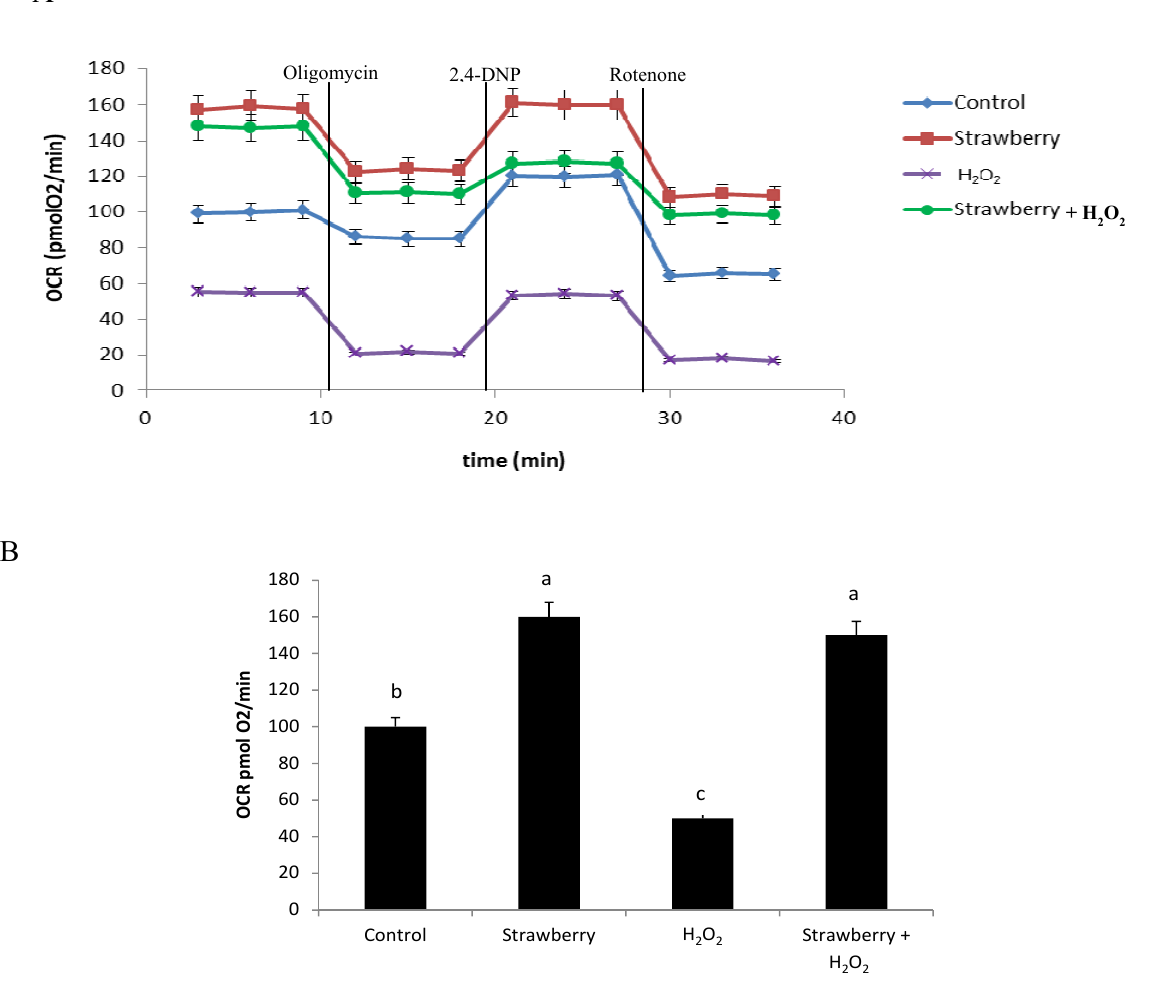
Figure 5. Evaluation of oxygen consumption rate (OCR) in control and in strawberry pre-treated fibroblasts, stressed with H Extracellular Flux Analyzer with the sequential injection of Oligomycin (1 µg/mL), 2,4-DNP (100 µM), Rotenone (1 µM) at the indicated time point into each well, after baseline rate measurement ( A ). Basal OCR levels in control, strawberry pre-treated fibroblasts and in cells stressed with H strawberry extract ( B